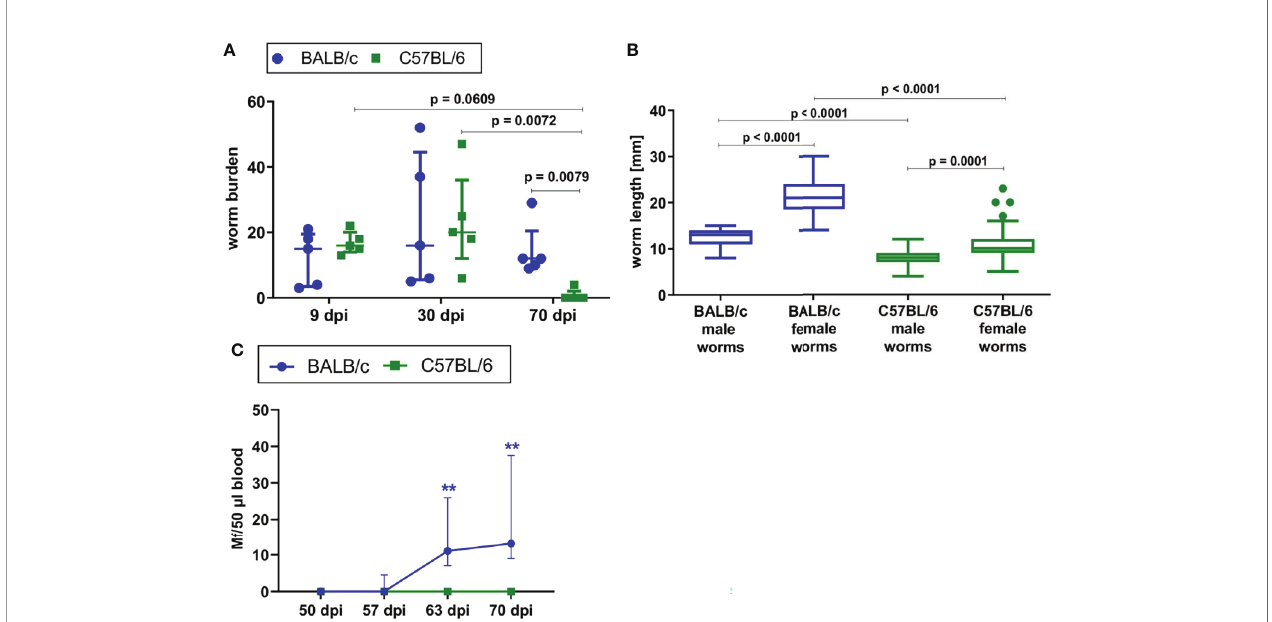
FIGURE 1 | BALB/c mice develop chronic L. sigmodontis infection, whereas C57BL/6 mice clear the infection after the molt into adult fi lariae. (A) Worm burden of naturally L. sigmodontis -infected susceptible BALB/c mice and semi-susceptible C57BL/6 mice 9, 30 and 70 days after infection (dpi). (B) Worm length [mm] of male and female fi lariae at 30dpi. (C) Micro fi lariae counts in peripheral blood over time. (A, C) n = 5, data are representative for 2 (9dpi) or 4 (30, 70dpi) independent experiments. B: n = 49-67 worms, data are representative for 4 independent experiments. (A) Data shown as median with IQR; Kruskal-Wallis with Dunn ’ s post-test. (B) Data shown as Box and Whiskers with Tukey; Kruskal-Wallis with Dunn ’ s post-test. (C) 2-way ANOVA and Bonferroni multiple comparison test. **p < 0.01 Mf: Micro fi